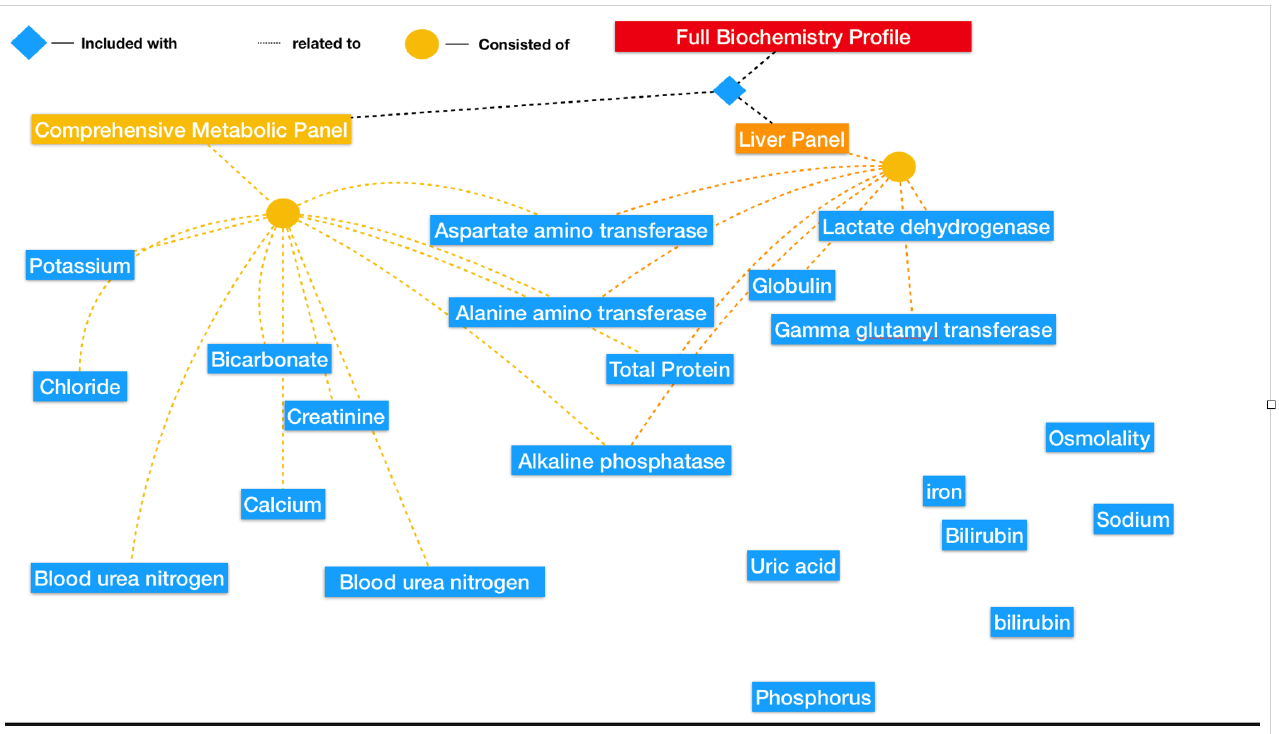
Figure 4. Full biochemistry profile—blood exams.